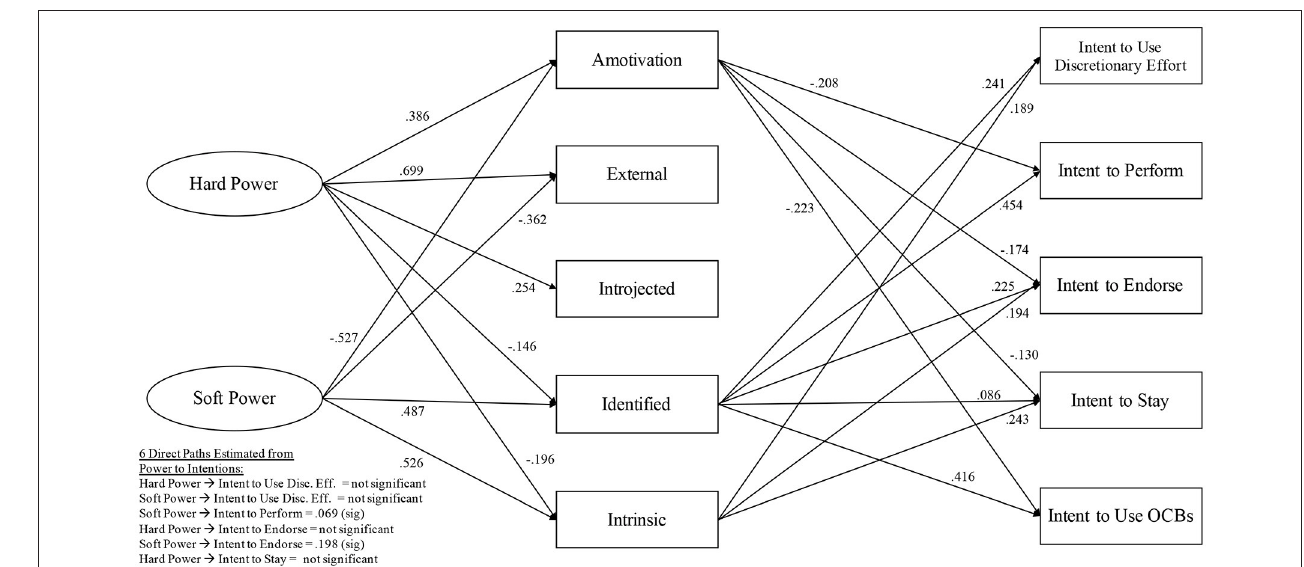
FIGURE 3 | Model 4, Final Model, Study 2 ( n = 1,039).